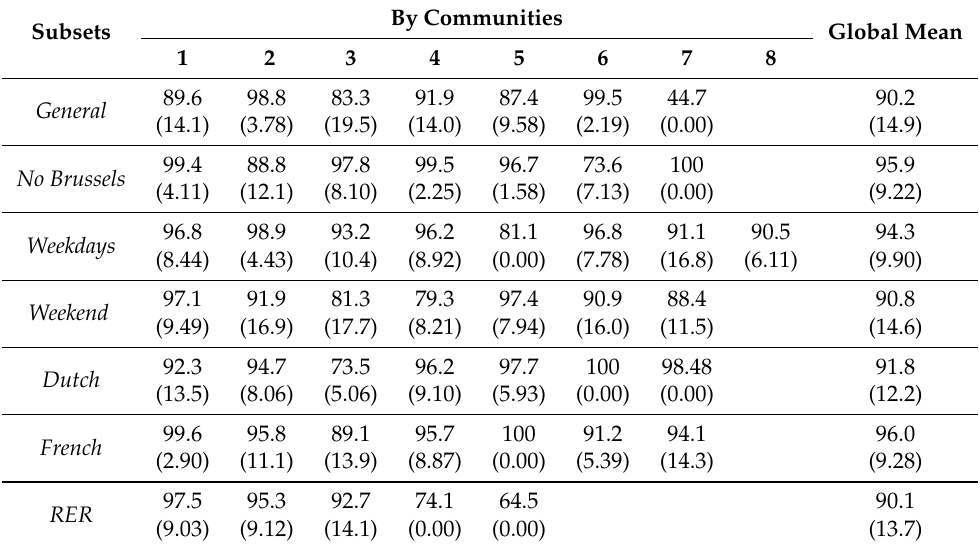
Figure A1. The stability of each community (Table 2) is computed as the average of this value over all nodes belonging to that community. We use this stability as a measure of the robustness of the partition obtained. Table 2. Average stability of the communities (in %; high values = high stability; between bracket = standard deviation). By Communities Subsets Global Mean